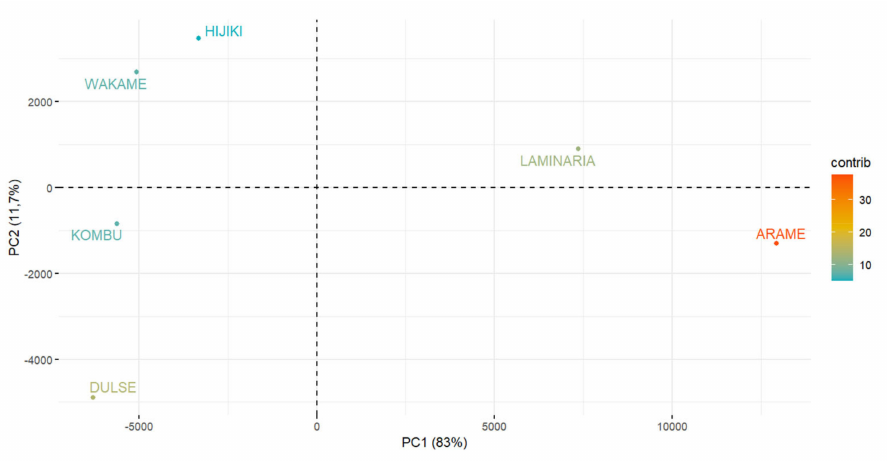
Figure 14. Principal component analysis of